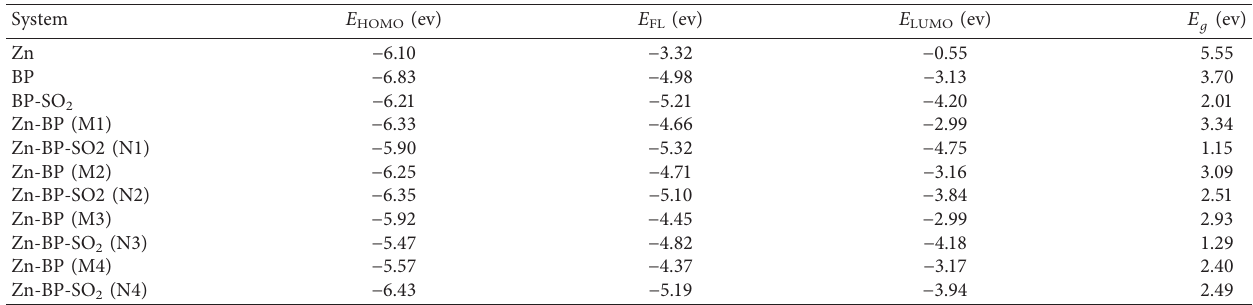
Figure 4: The molecular electrostatic potential map of different systems: (a) B Table 2: The orbital parameters, HOMO-LUMO energies, fermi level, and HOMO-LUMO energy gap of different systems.